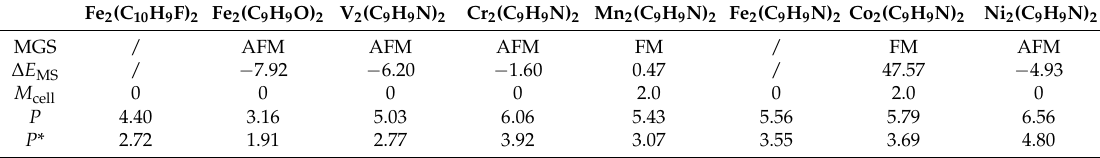
Table 6. Magnetic ground state (MGS), energy difference between AFM and FM states ( ∆ E MS = E AFM − E FM , meV/per cell), magnetic moment ( M cell , µ B), polarization ( P , µ C/cm 2 ) by Berry’s phase calculations, and polarization ( P *, µ C/cm 2 ) calculated by summing the dipole moment of isolated molecules for triclinic polar metallocenes with the FE